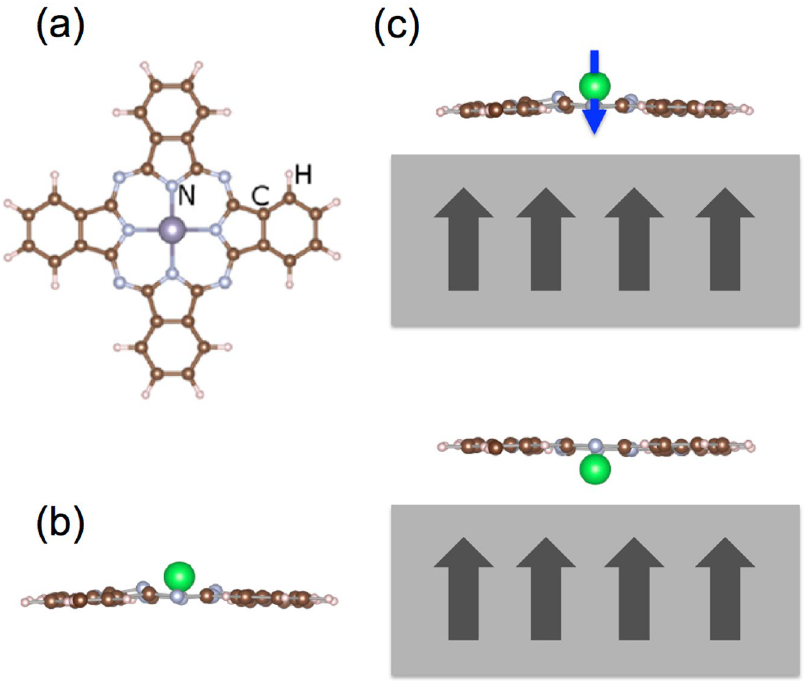
Figure 1. ( a ) Chemical structure of a M-Pc molecule. ( b ) Side view of the special type of M-Pc molecules exhibiting a shuttlecock shape, ( c ) Sketch of the concept of a molecular magnetic button: A M-Pc molecule is adsorbed on a magnetic substrate. Depending on the adsorption configuration, i.e. whether the metal ion is above the molecular plane or between the molecular plane and the substrate surface, the metal ion exhibits a magnetic moment or